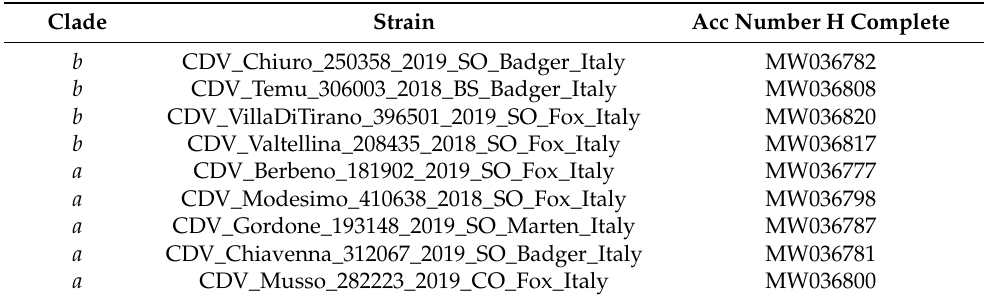
Table 1. Italian CDV strains representatives of clades a and b , for which the complete H gene is given. Clade Strain Acc Number H Complete b CDV_Chiuro_250358_2019_SO_Badger_Italy